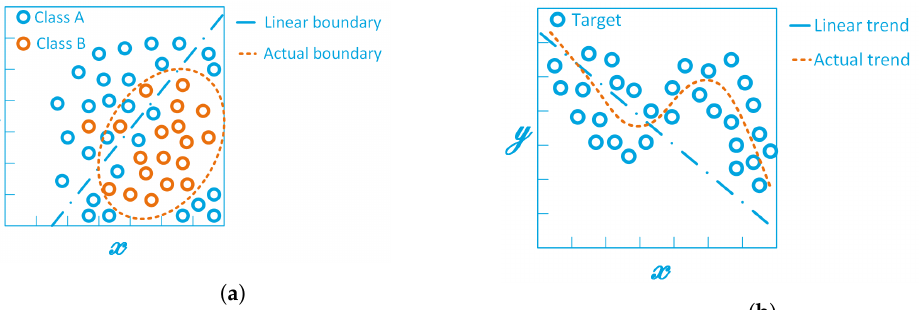
Figure A2. Linear approximation of the prediction function for ( a ) a binary classifier with a non-linear boundary, and ( b ) a dataset with non-linear